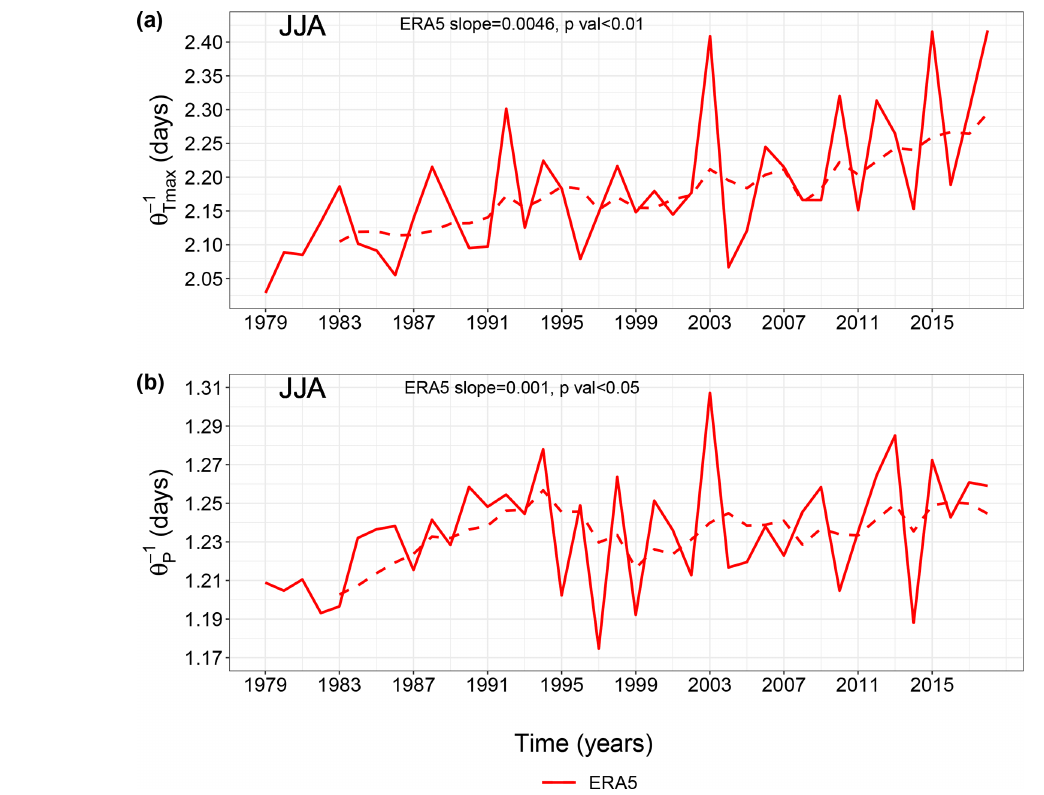
− 1 ) and (b) P ( θ − 1 ). P T max